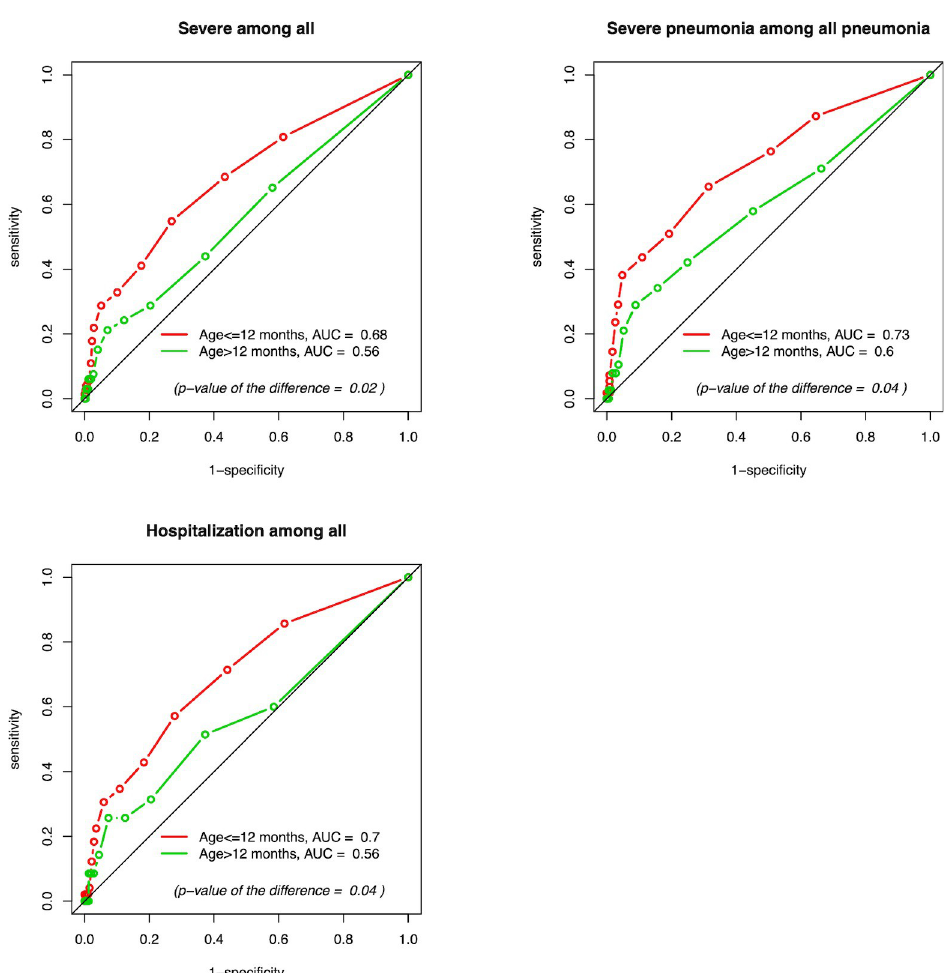
Fig 4. ROC curves stratified by age to predict: Severe diseases among all illness episodes, severe pneumonia among all pneumonias episodes and hospitalizations among all illness episodes.